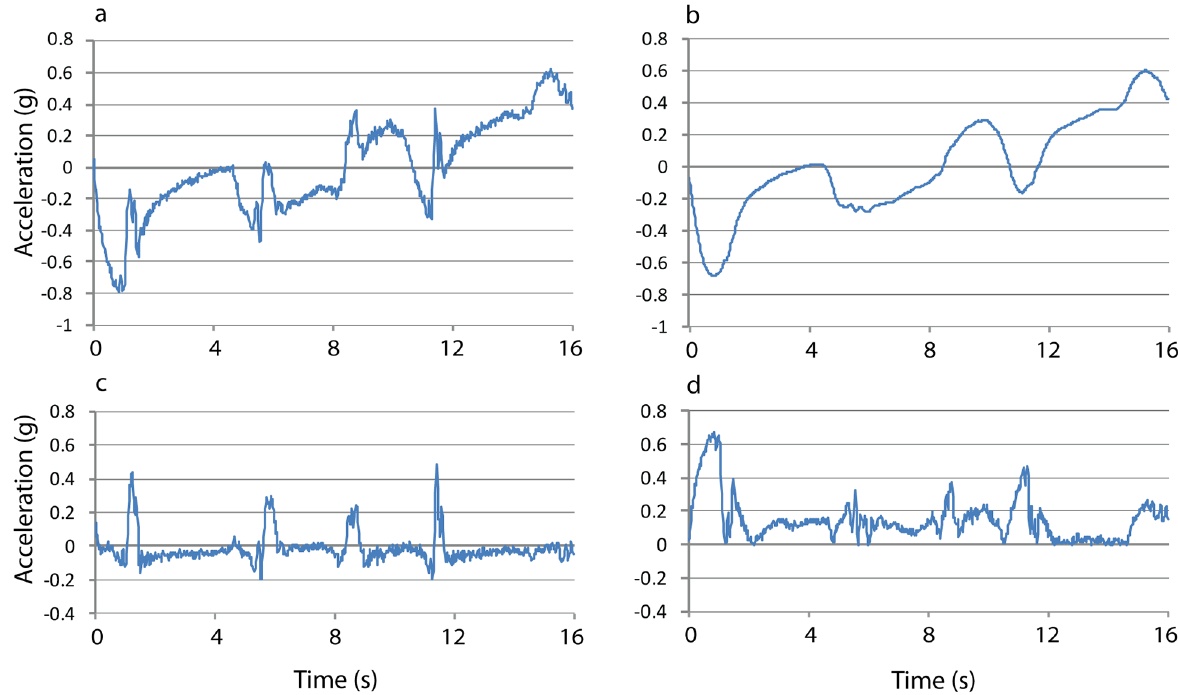
Fig 5. The raw x-axis acceleration signal (a) and estimated (gyro-informed) acceleration due to gravity (b) of a female Steller sea lion that stroked four times during a single dive. The difference between the curves in panels a and b equals the forward acceleration in the tag ’ s x-axis (GIDA) (c). The result from subtracting the smoothed accelerometer signal from the unfiltered for the tag ’ s x-axis (d). (Animal F00BO, July 30 th , 6 kph).